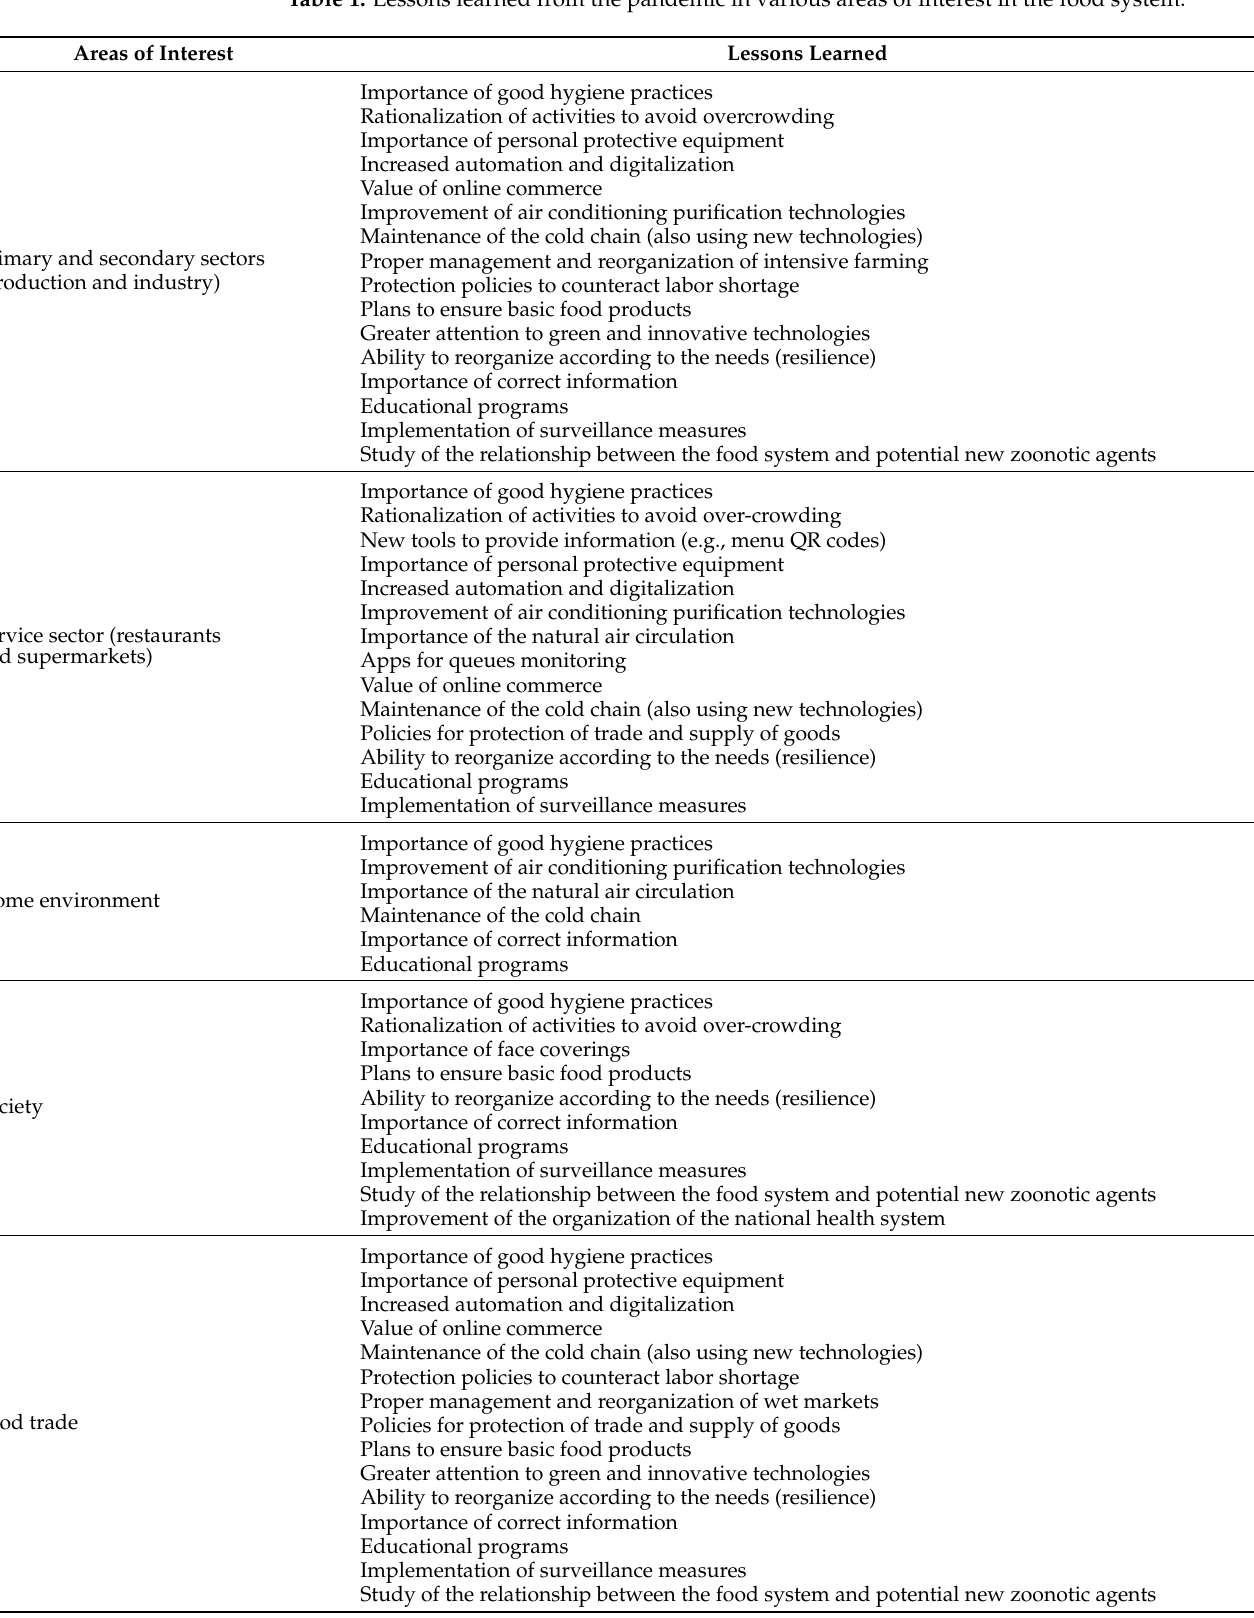
Table 1. Lessons learned from the pandemic in various areas of interest in the food